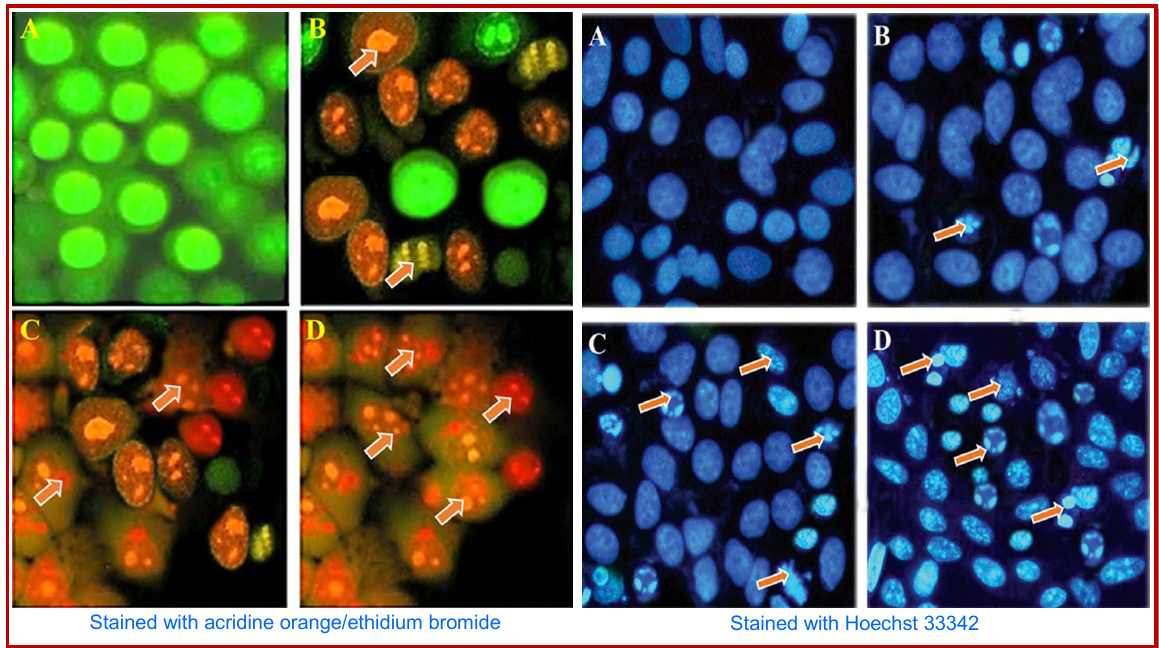
Figure 2: Left two columns: Apoptosis induced by naringenin chalcone in U87MG human glioblastoma cells after the cells were treated with naringenin chalcone. The cells were treated with 0, 10, 50 and 100 µ Μ of drug, stained with acridine orange/ethidium bromide, then observed under fluorescence microscope at 400x magnification. Red and orange fluorescence indicates cells under- going apoptosis. Right two columns: Apoptosis induced by naringenin chalcone in U87MG human glioblastoma cells after the cells were treated with naringenin chalcone. The cells were treated with 0, 10, 50 and 100 µ Μ of drug, stained with Hoechst 33342, then observed under fluorescence microscope at 200x magnification. Arrows indicates cells undergoing apoptosis (bright fluores- cence)